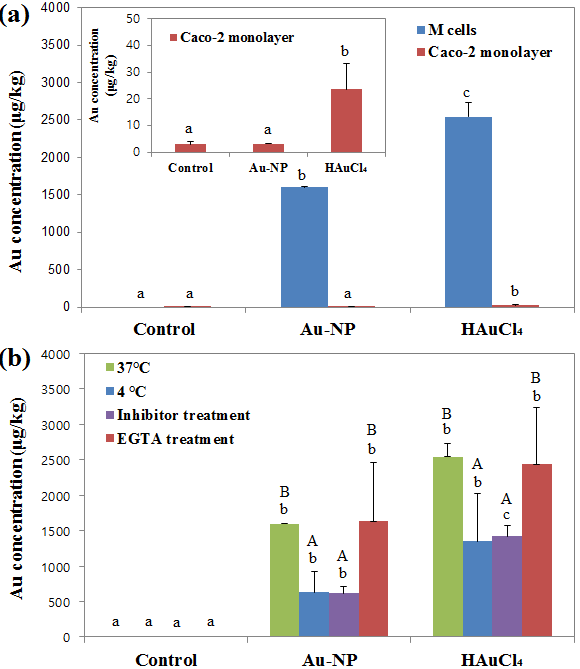
Figure 3. ( a ) Intestinal transport of Au-NPs or Au 3+ ions using an in vitro follicle-associated epithelium (FAE) model and Caco-2 monolayers; ( b ) Transport amounts of Au-NPs or Au 3+ ions at different temperatures (37 ◦ C and 4 ◦ C), after pre-treatment with a clathrin-mediated endocytosis inhibitor, chlorpromazine, and after ethylene glycol tetraacetic acid (EGTA) treatment. a − c Different letters in bars indicate significant differences among control (medium), Au-NP-, and Au 3+ ion-treated groups ( p < 0.05). A,B Different letters in bars indicate significant difference in uptake amounts at 37 ◦ C and 4 ◦ C, with/without inhibitor treatment, and with/without EGTA treatment ( p < 0.05).